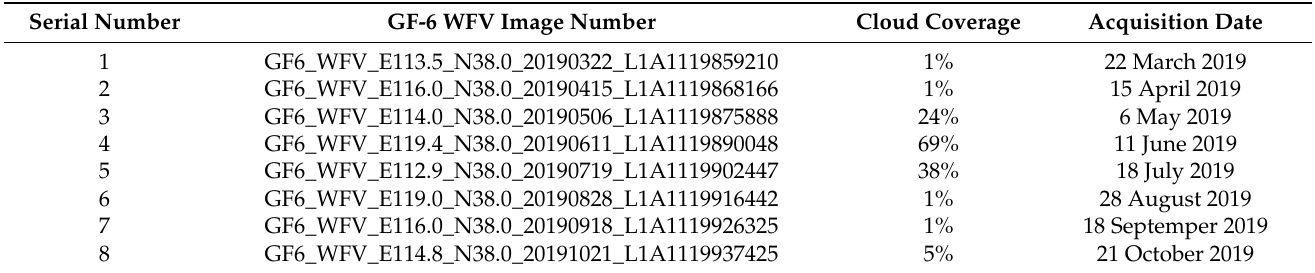
Table 2. GF-6 WFV data list.